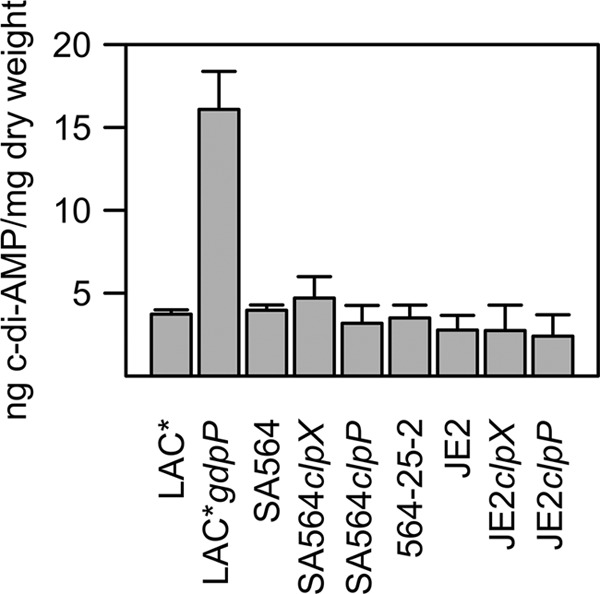
Cyclic-di-AMP levels in S. aureus are not affected by inactivation of clpX or clpP. Data represent intracellular c-di-AMP concentrations. The concentrations of c-di-AMP in the cytoplasm of strains LAC*, LAC* gdpP, SA564, SA564 clpX, SA564 clpP, 564-25-2 (clpX ltaS), JE2, JE2 clpX, and JE2 clpP were determined by LC-MS/MS. Values indicate c-di-AMP levels per milligram of bacterial dry weight, and the averages and standard deviations of results from three replicates are plotted.